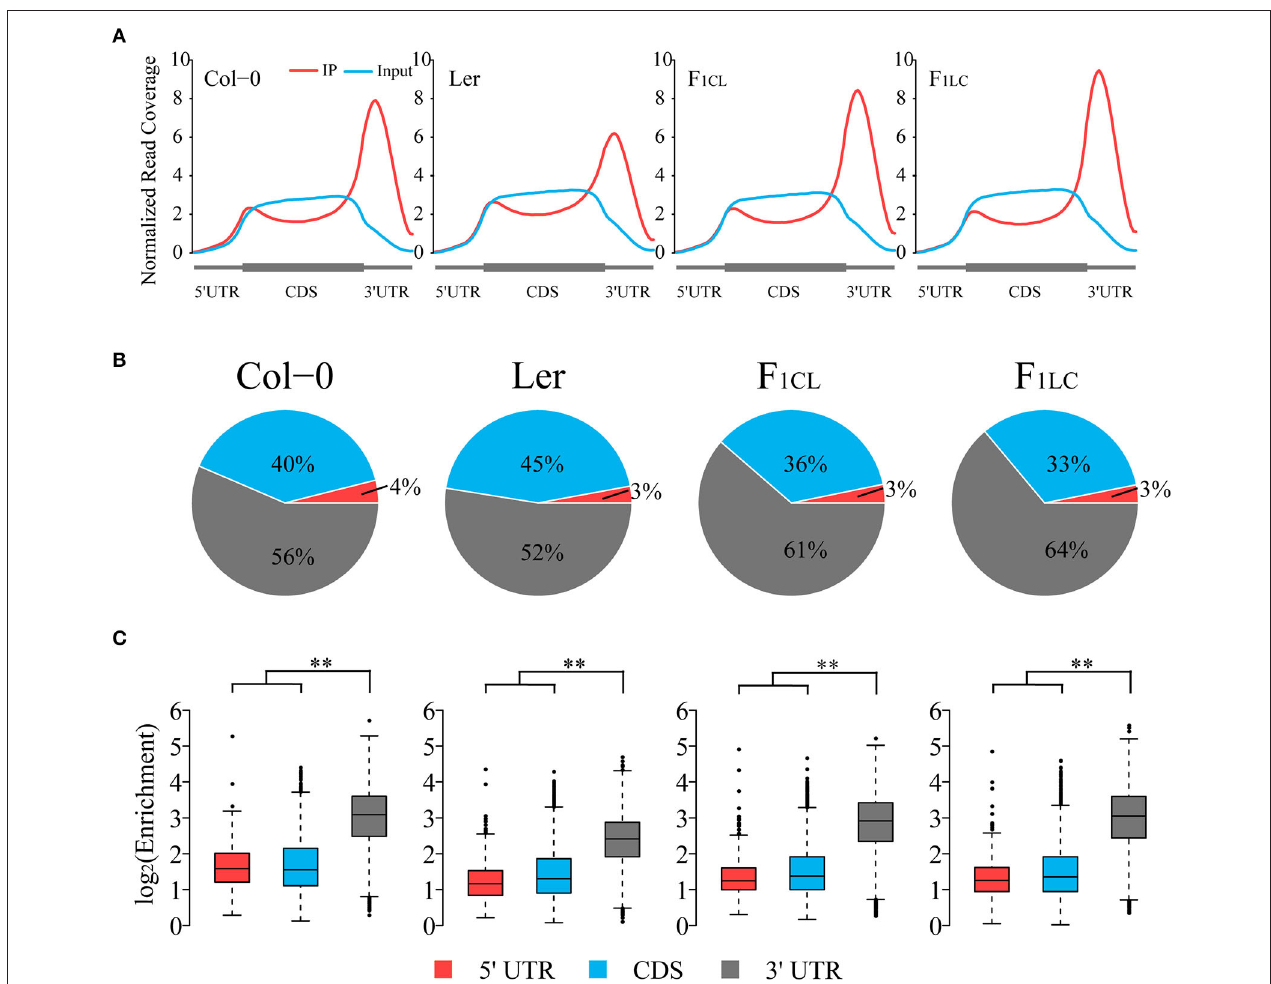
FIGURE 1 | Global pattern of m 6 A peaks in Col-0, Ler, and their F 1 reciprocal hybrids. (A) Coverage of normalized reads along transcripts. Each transcript is divided into three non-overlapping features: 5’ UTR, CDS, and 3’ UTR. (B) Distribution of m 6 A peaks in transcript features of parents and hybrids. (C) Relative enrichment of m 6 A peaks of each transcript feature. Enrichment = Normalized m 6 A-seq reads divided by normalized input reads of each peak. ** p < 2.2e − 16, Wilcoxon rank-sum